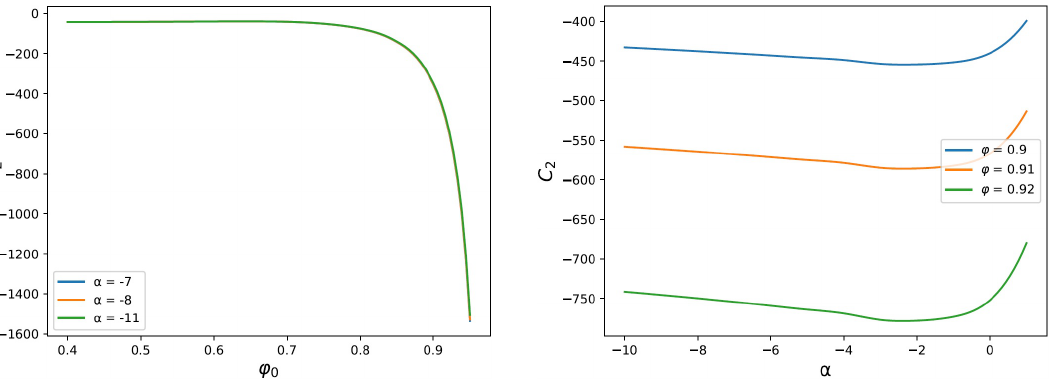
Figure 11 . Left: the integration constant C 2 as a function of ϕ 0 for fixed values of α for Nut end-point solutions. Right: the integration constant C Nut end-point